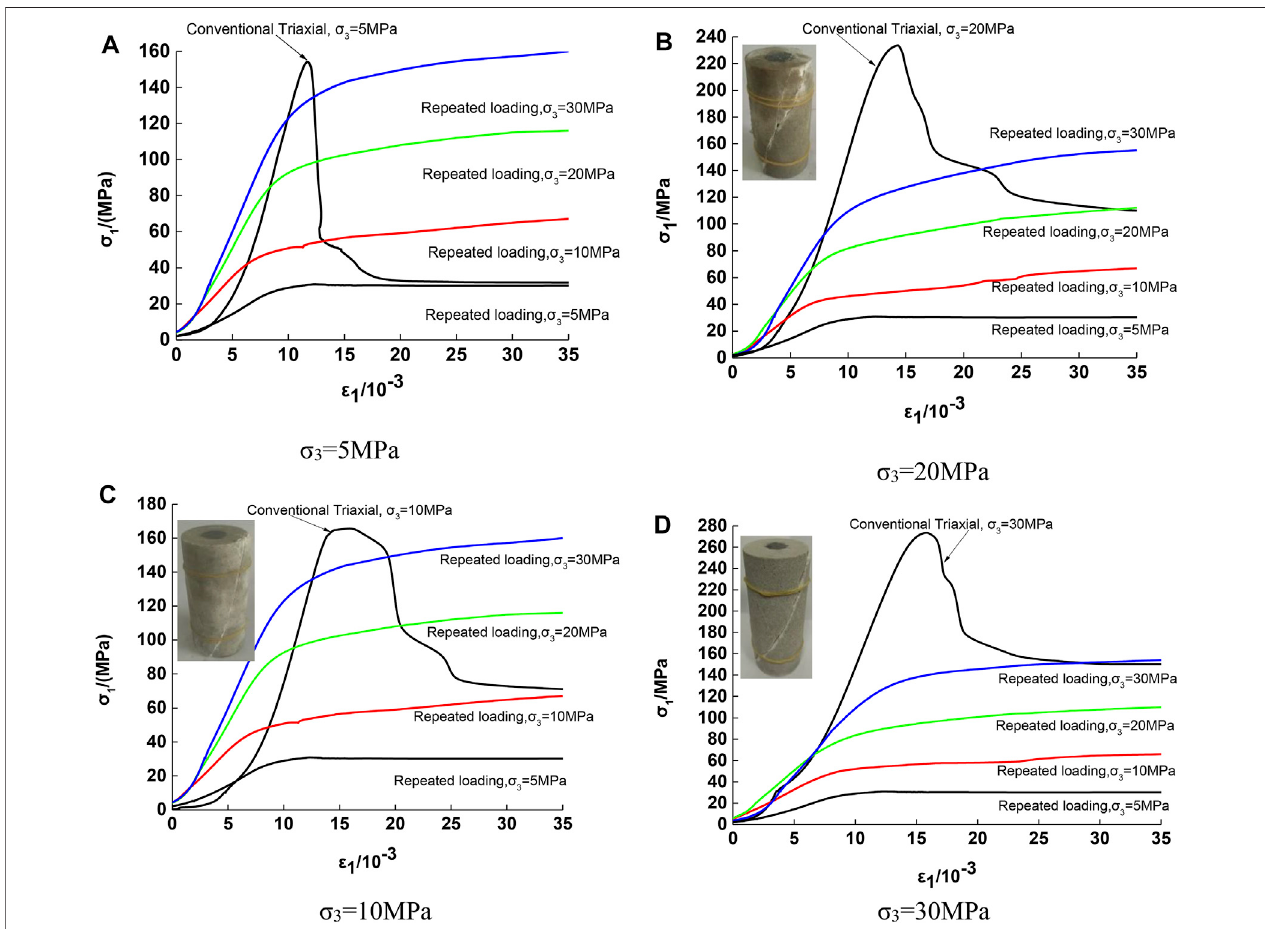
FIGURE 2 | Stress-strain curves of conventional triaxial compression test and single specimen repeated loading test under different con fi ning pressures. (A) σ σ σ σ 3 =5MPa. (B) 3 =10MPa. (C) 3 =20MPa. (D) 3